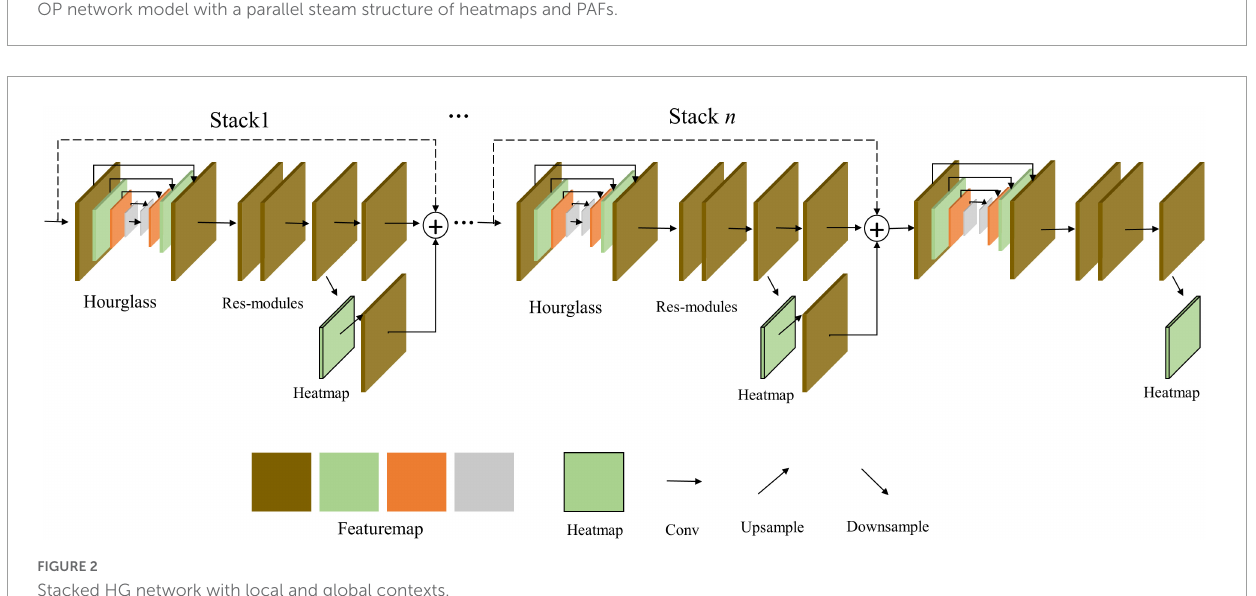
FIGURE2 Stacked HG network with local and global